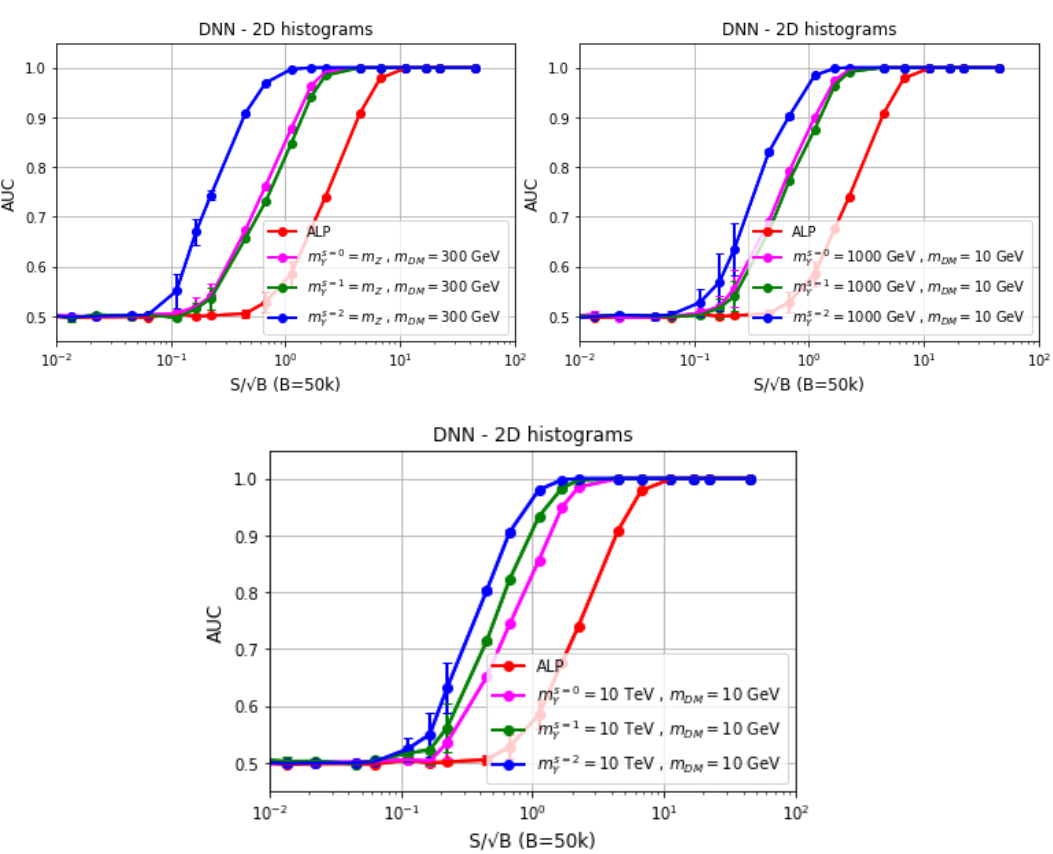
Figure 7: AUC results for several benchmark models, using DNN and 2D histograms as input data. Each model is tested independently in a binary classifier to distinguish new physics plus SM vs SM-only histograms. The training procedure was repeated 10 times and the largest and smallest AUC values where removed from each DNN to calculate the AUC mean with its standard deviation. Error bars are included for all